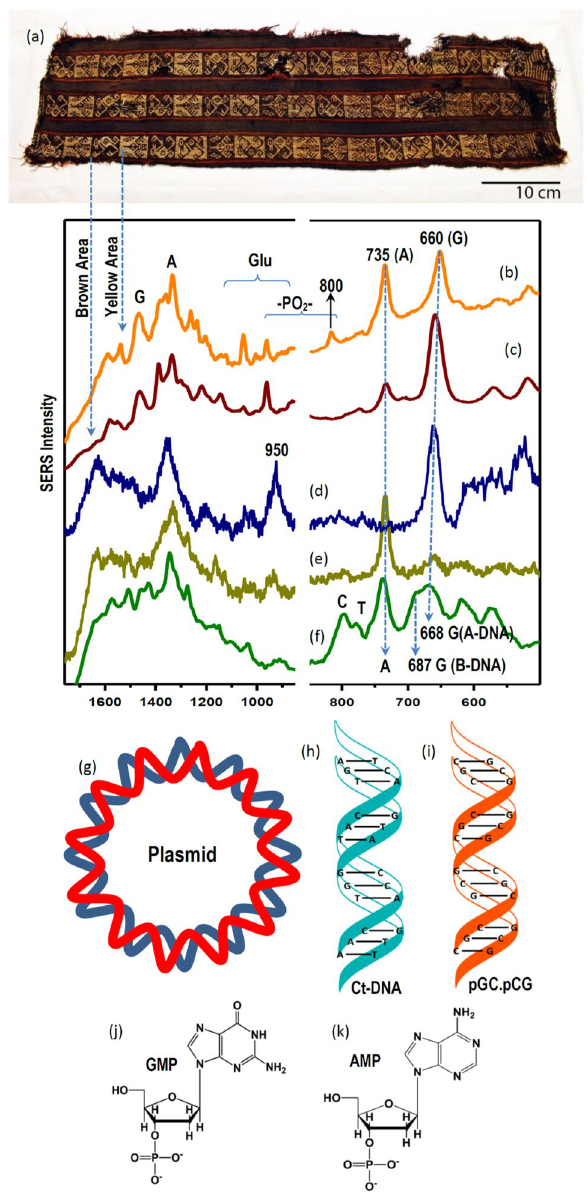
( d ), pGC.pCG ( e ), and plasmid ( f ). Schemes of the plasmid ( g ), ct-DNA ( h ) and pGC.pCG ( i ), and structure of guanosin monophosphate (GMP) ( j ) and adenosine monophosphate (AMP) ( k ) by using Ag citrate